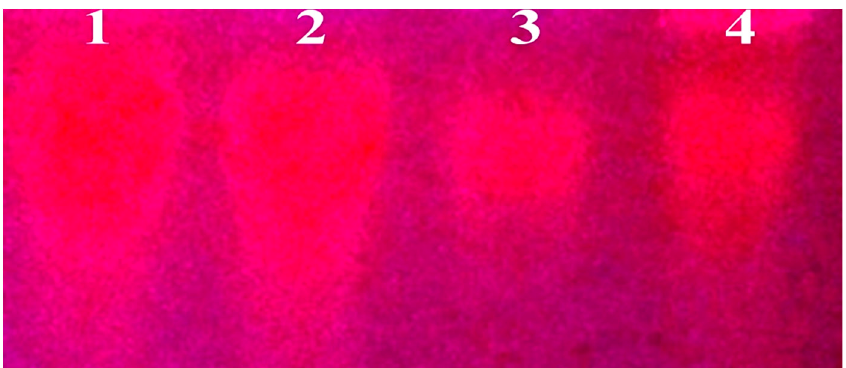
Figure 2. The ethidium bromide displacement assay: gel electrophoresis showing the chemical nuclease activity of CT-DNA by the synthesized ligand ( HL ) and its complexes ( 1b – 2b ) in the presence of hydrogen peroxide. Lane: 1 DNA alone + H 2 O 2 ; Lane: 2 ligand ( HL ) + DNA + H 2 O 2 ; Lane: 3 complex ( 1b ) + DNA + H 2 O 2 ; Lane: 4 complex ( 2b ) + DNA + H 2 O 2 .